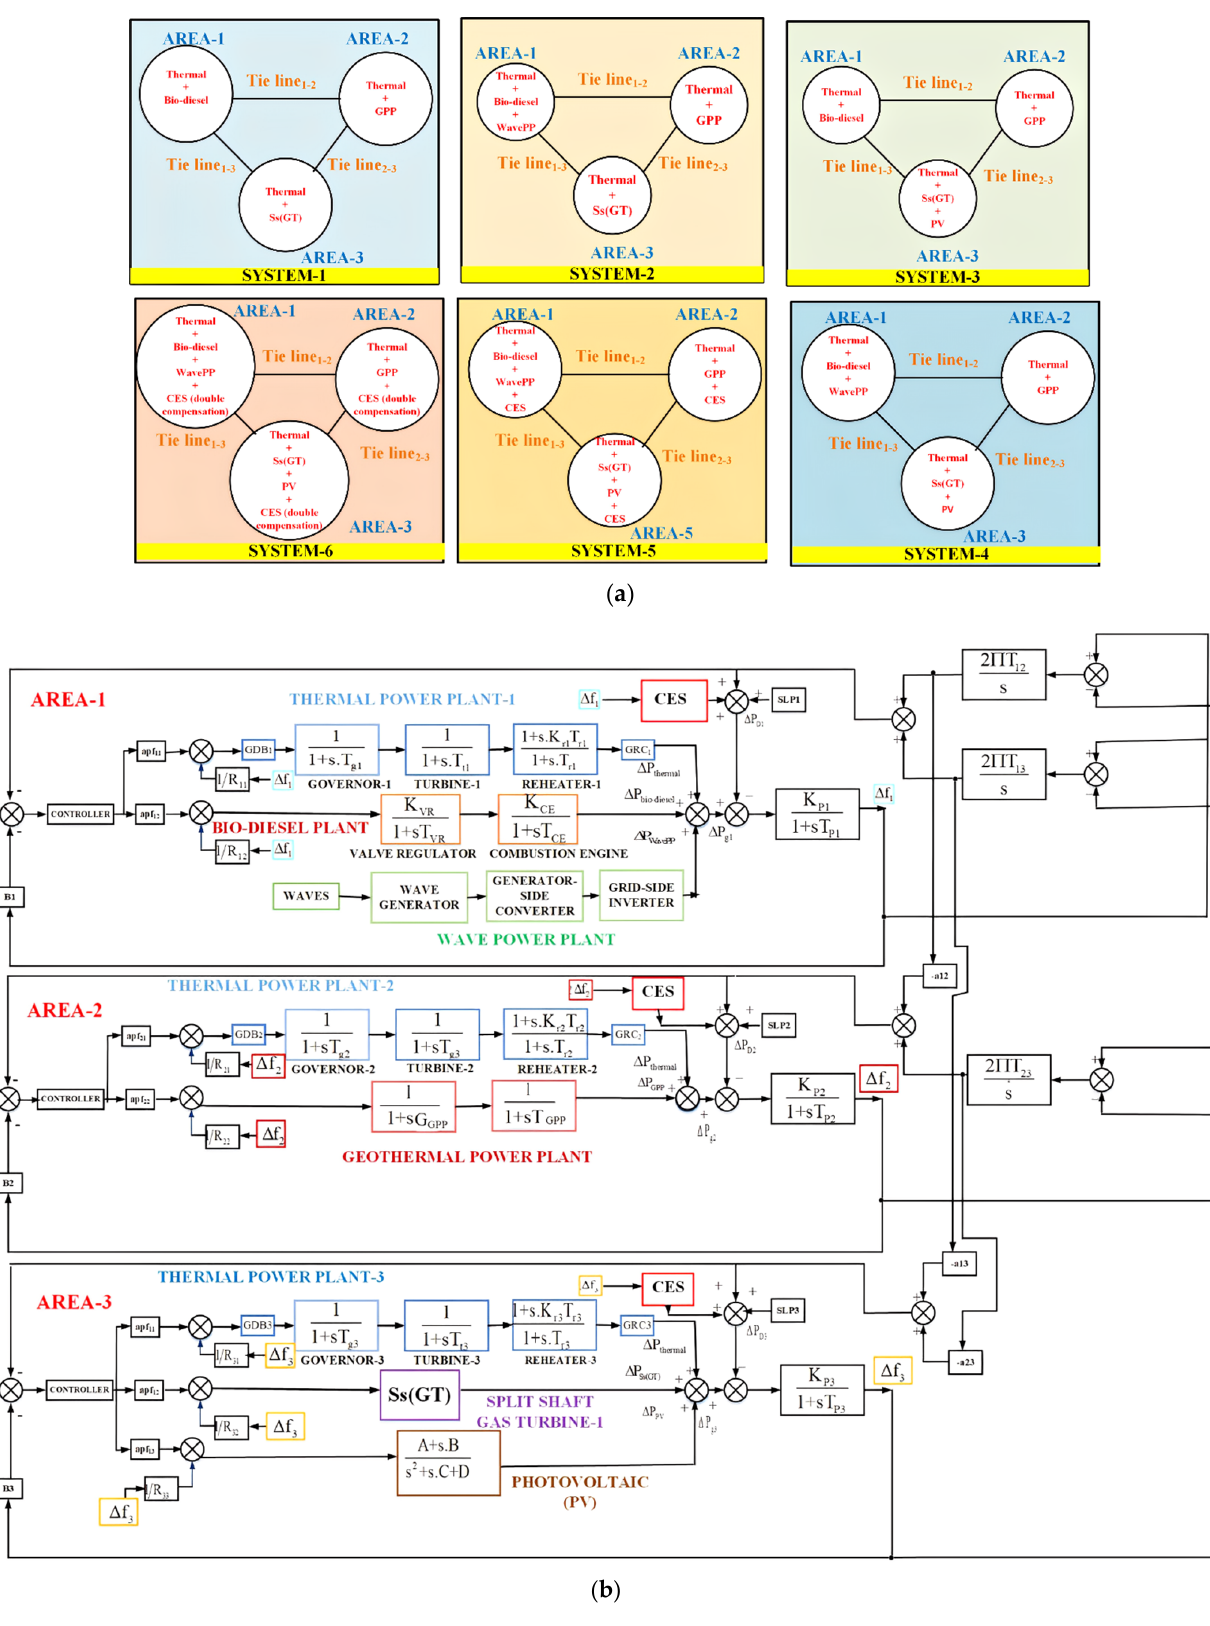
Figure 2. The representation and Tfn model of an unequal three-area system with thermal – biodiesel – WavePPt in area-1, thermal – GPP in area-2, and thermal – Ss (GT) – PV in area-3: ( a ) Schematic diagram of six different systems in a step-by-step method, ( b ) Tfn model of the ultimate system.